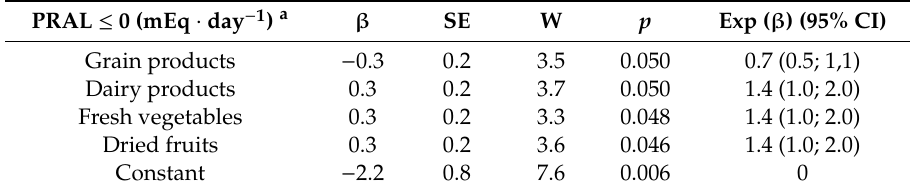
Table 4. E ff ects of athletes’ eating habits on their dietary PRAL.